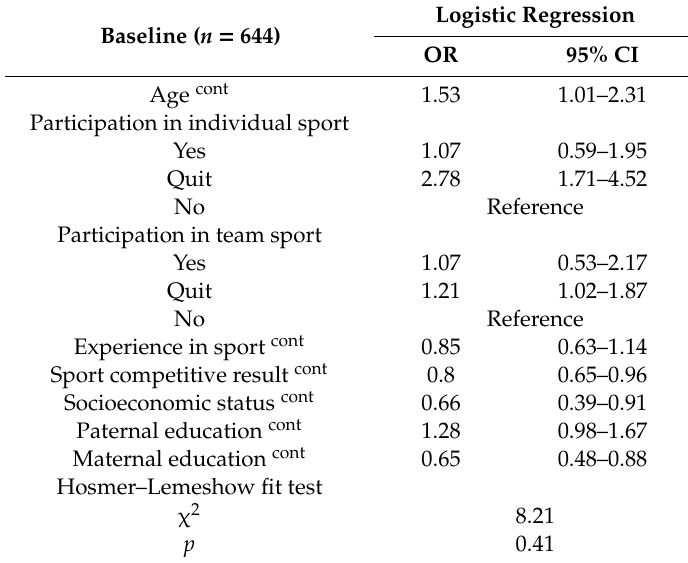
Table 1. Correlates of cannabis misuse at baseline (adjusted for gender and urban/rural environment). OR—odds ratio; CI—confidence interval.